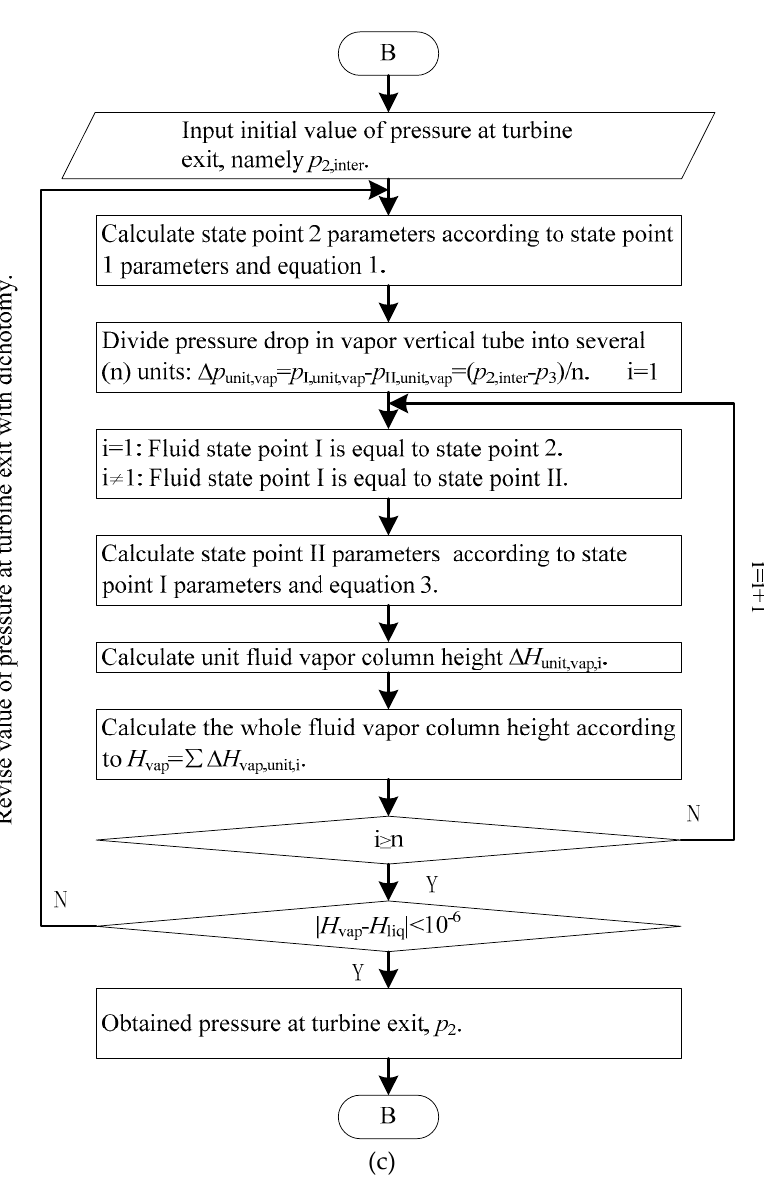
Figure 3. Block diagram for the theoretical analysis method for GDOPC. (a) Whole block diagram; (b) Details for process 5 to 6; (c) Details for process 2 to 3.